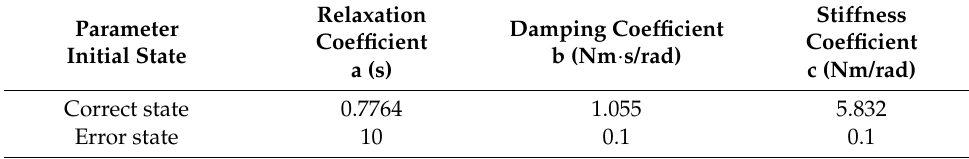
Table 2. Initial parameter setting of rubber model.